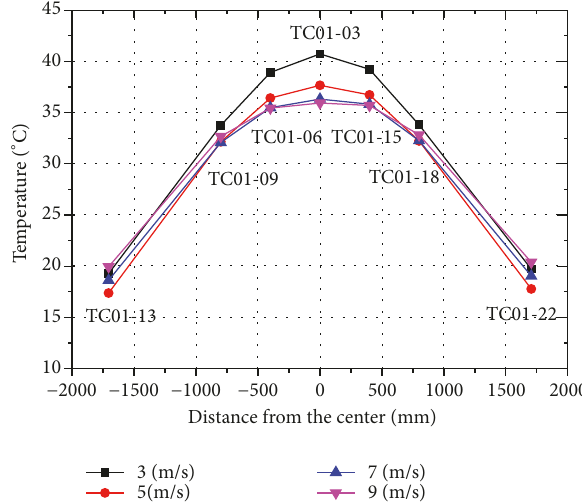
Figure 22: The effect of inlet cooling air velocity on support bottom